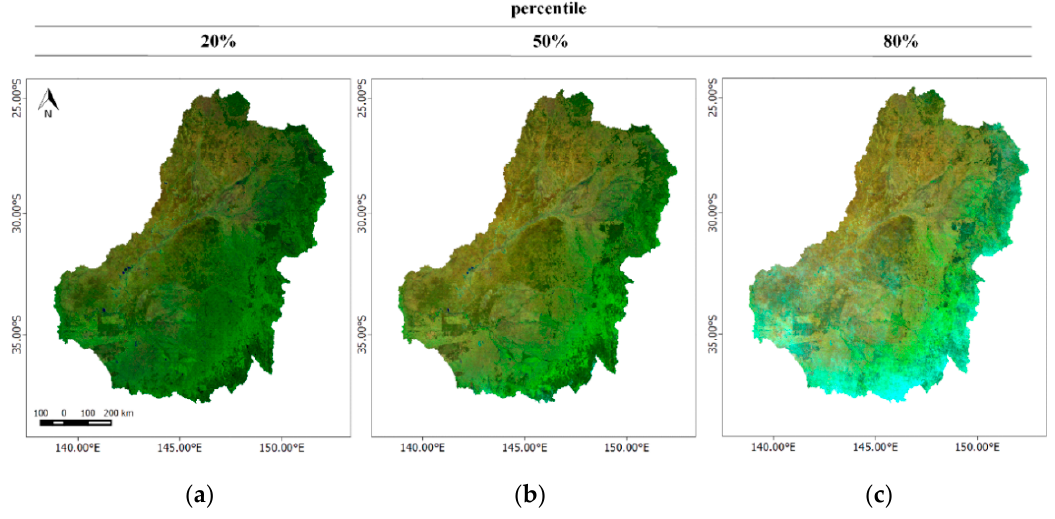
Figure 5. Intensity percentile false-color image (SWIR1, NIR, green) based on 2743 Landsat 8 images for 2013–2015, 20% ( a ); 50% ( b ); and 80% ( c ).